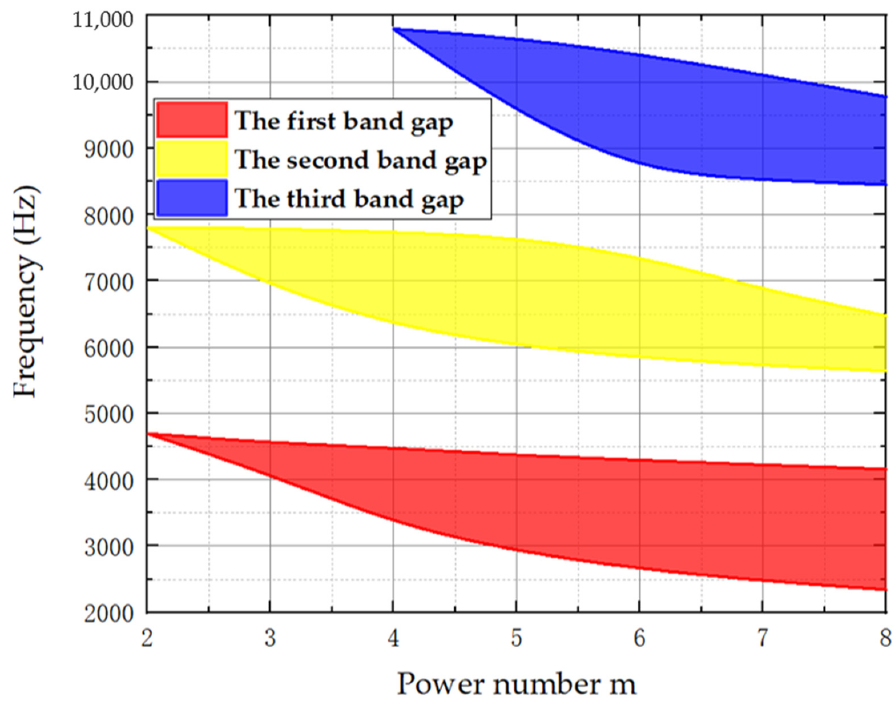
Figure 14. Influence of power number of the power-exponent prismoid edge on the band gaps.